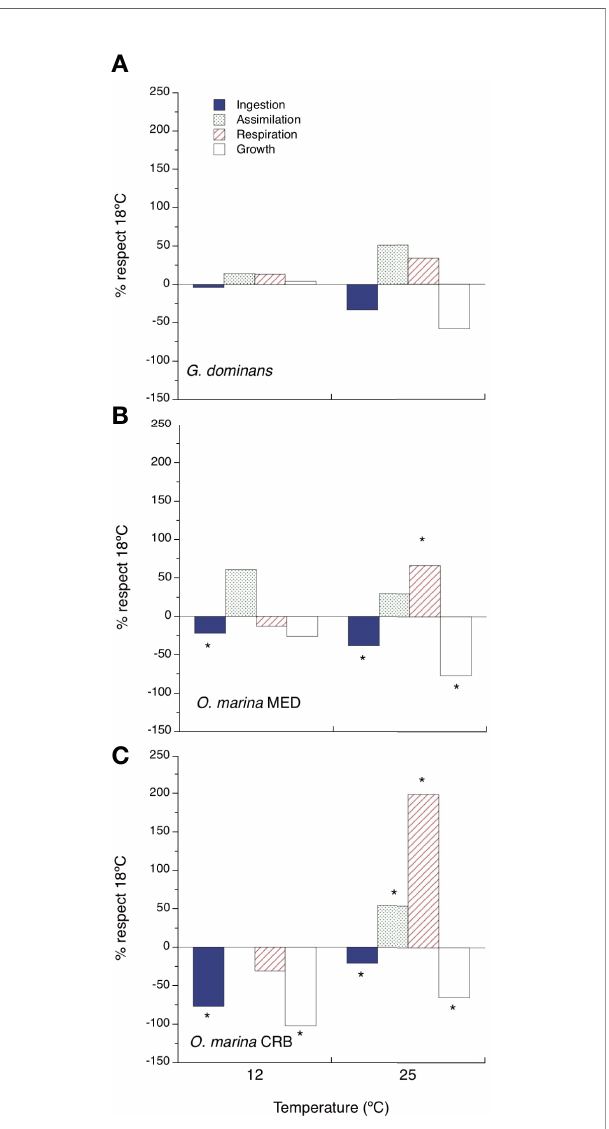
FIGURE 3 | Relative effects of temperature on the metabolic balance. The fi gure shows the percentage of change respect to 18°C for different metabolic rates at 12 and 25°C. (A) G dominans , (B) O. marina MED, and (C) O. marina CRB. Asterisks indicate signi fi cant differences (p<0.05,